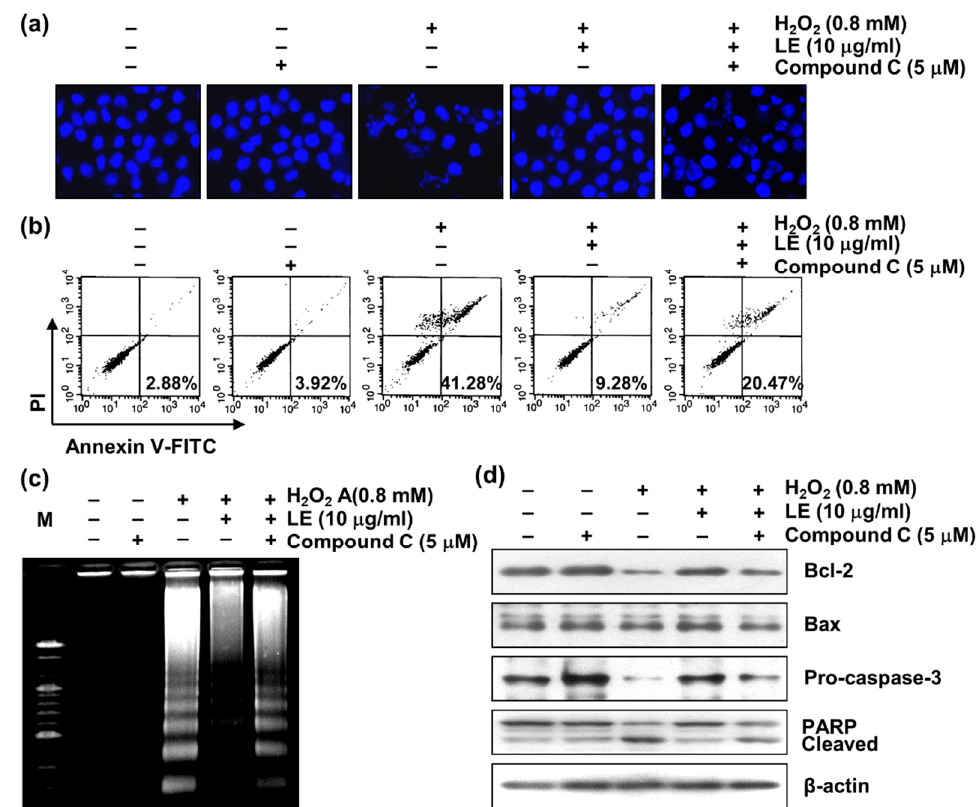
Figure 8. AMPK-dependent effect of LE on H 2 O 2 -induced apoptosis in C2C12 cells. Cells were pre- treated with 5 μ M compound C, with or without 10 μ g/mL LE, for 1 h and then treated with 0.8 mM H 2 O 2 for 24 h: ( a ) Induction of apoptosis was analyzed by measuring cells with condensed nuclei (blue color) later staining with 4 ′ ,6 ′ -diamidino-2-phenylindole (DAPI) staining. Representative results of three independent experiments are shown; ( b ) Cells were stained using Annexin V-FITC/PI and then measured using flow cytometry. Representative results of three independent experiments are shown; ( c ) Fragmented genomic DNA was extracted from cells and measured using agarose gel electrophoresis. M, Marker. Representative results of three independent experiments are shown; ( d ) Expression profiles of Bcl-2, Bax, pro-caspase-3, and PARP proteins. Western blot analysis was per- formed using β -actin was as a loading control. Representative results of three independent experi- ments are shown. Bcl-2, B-cell lymphoma 2; Bax, Bcl-2-associated X protein; PARP, poly(ADP-ri- bose) polymerase.